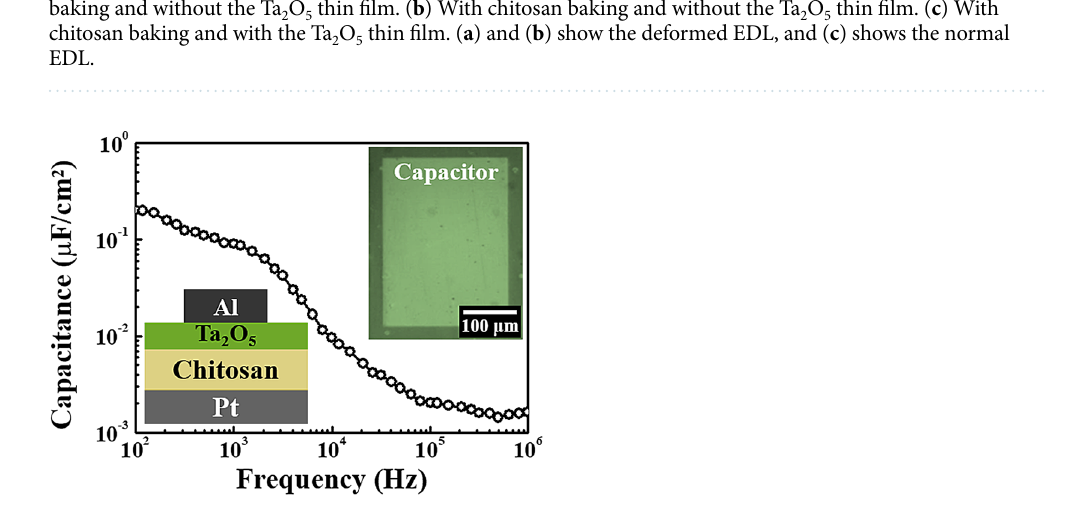
Figure 3. Capacitance–frequency (C– f ) curve for the chitosan electrolyte-Ta 2 O 5 hybrid EDLC that is measured in the frequency range from 10 2 to 10 6 Hz. The insets show the schematic and the optical microscope image of the hybrid